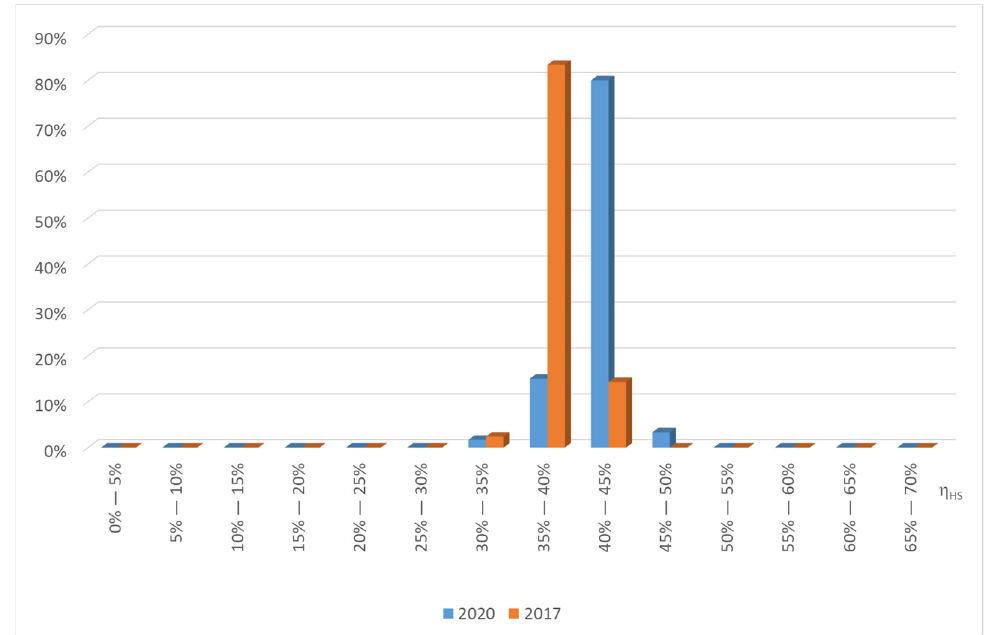
Figure 14. Frequency distribution of the hybrid system efficiency values.